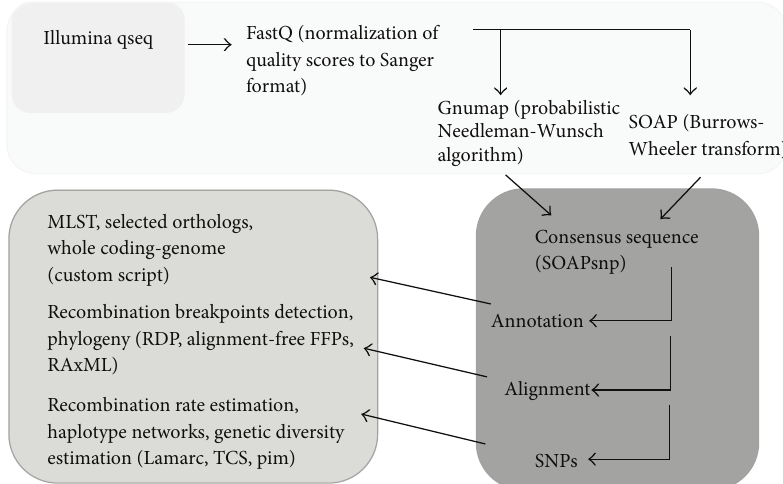
Figure 5: Data Analysis Pipeline . SOAPsnp was used to find SNPs in the data. The criteria for SNP validation in SOAPsnp is rather low. Variant validation is highly critical in metagenomic samples, more so than with homogeneous samples. False variants created by sequencer error can quickly change the results of forensics analysis in metagenomic samples where lower coverage depth and partial base consensus conditions are expected, whereas base consensus can be demanded in homogeneous sample data